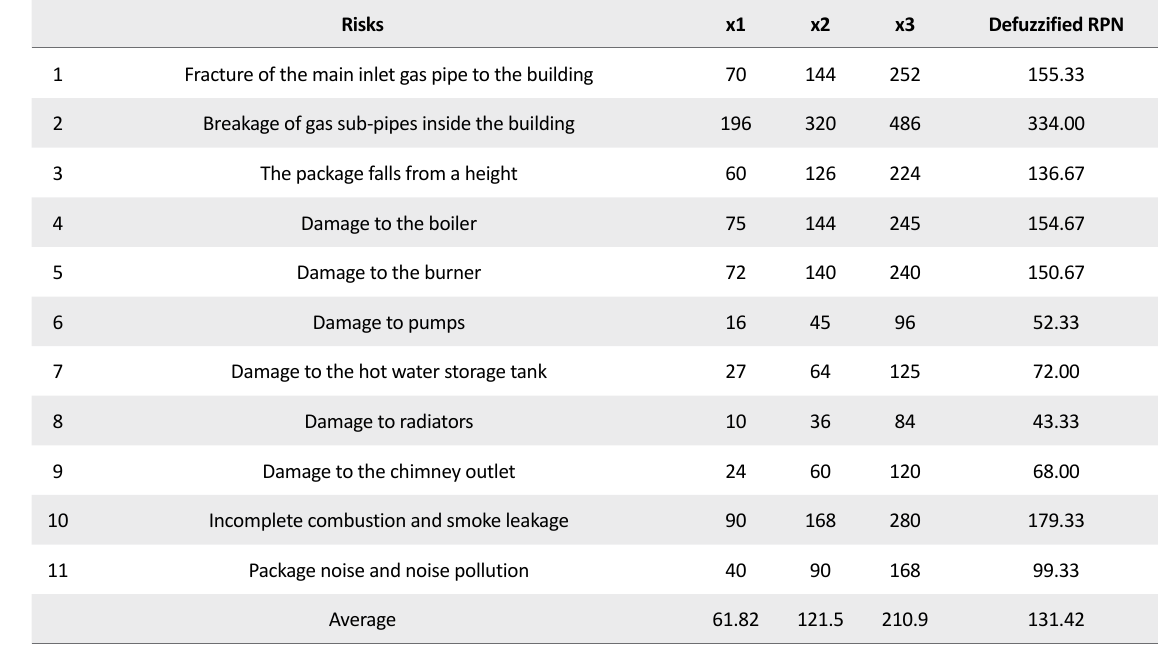
Table 7. Defuzzified RPN values for the risk of HPs